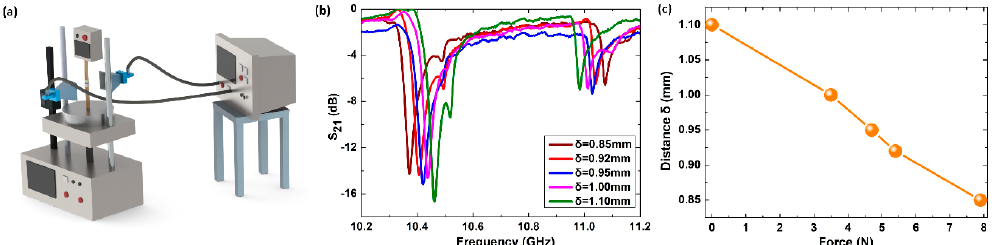
Figure 3. ( a ) Schematic diagram for mechanic-microwave measurement setup. ( b ) Measured transmission curves of metamolecule with various distances δ . ( c ) Measured distances δ under different applied forces F.